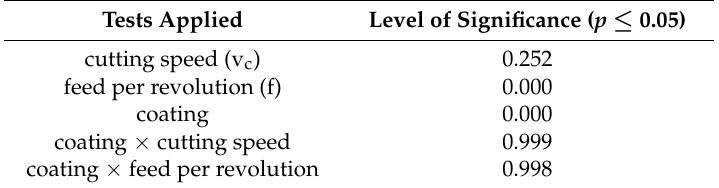
Table 7. Significance level of the effect of cutting parameters on the roughness average